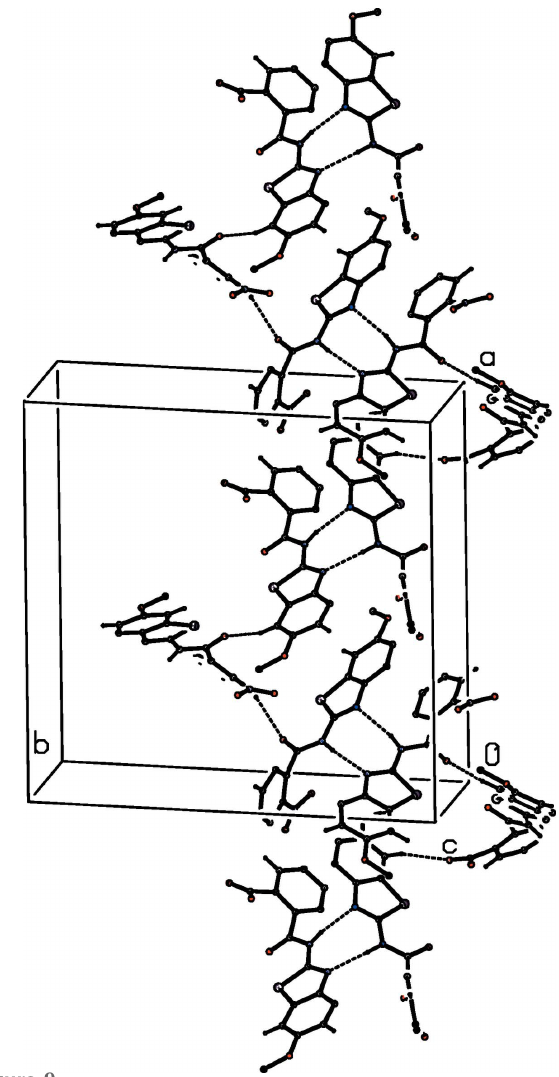
Figure 9 Part of the crystal structure of (II) showing the formation of a chain of rings running parallel to [100] and built from N—H (cid:3)(cid:3)(cid:3) N and C—H (cid:3)(cid:3)(cid:3) O hydrogen bonds. Hydrogen bonds are drawn as dashed lines and, for the sake of clarity, the H atoms not involved in the motifs shown have been